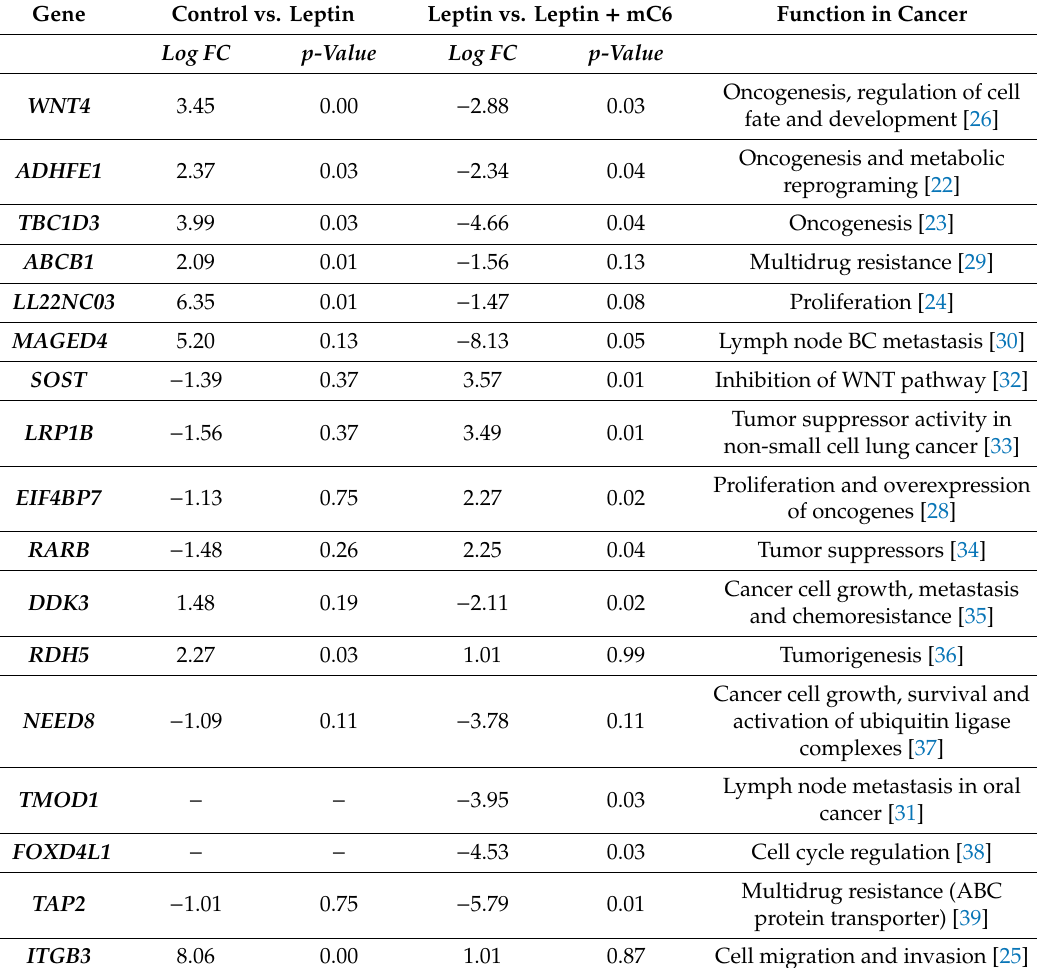
Table 1. Leptin-induced di ff erential expression of genes associated with cancer progression in triple-negative breast cancer cell